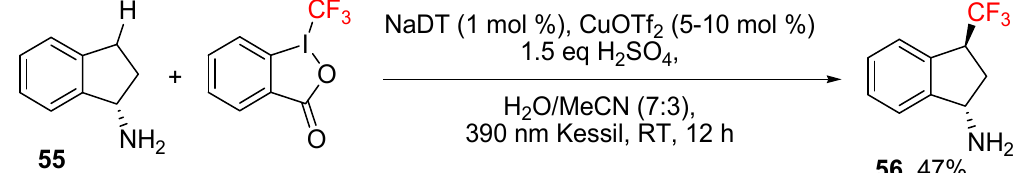
Scheme 33. Metallaphotoredox trifluoromethylation of compound 55 by Togni reagent II leading to 1-CF 3 -aminoindane 56 .